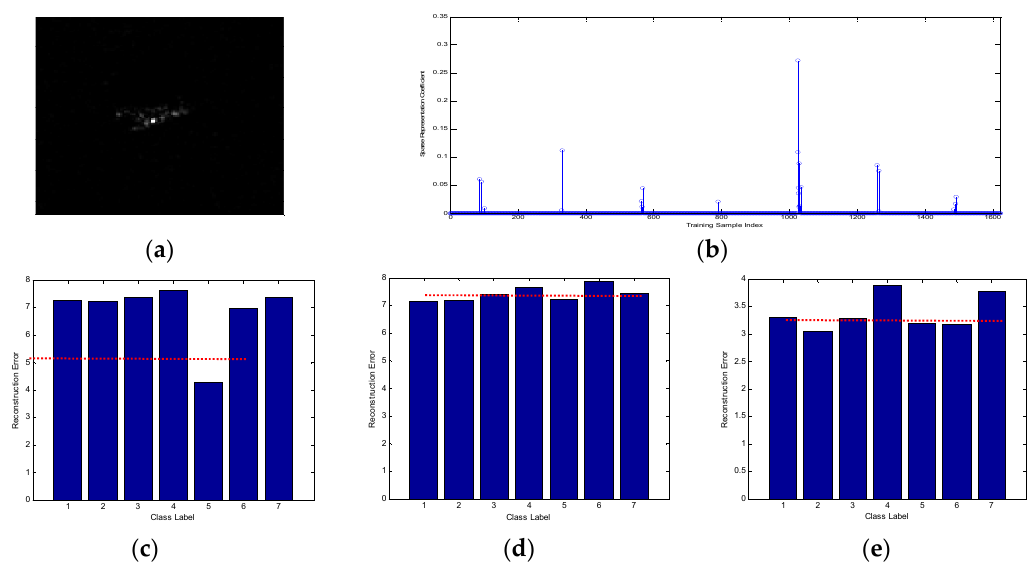
Figure 10. ( a ) Test sample T72-132; ( b ) Sparse vector obtained based on ADNNLS algorithm; ( c )